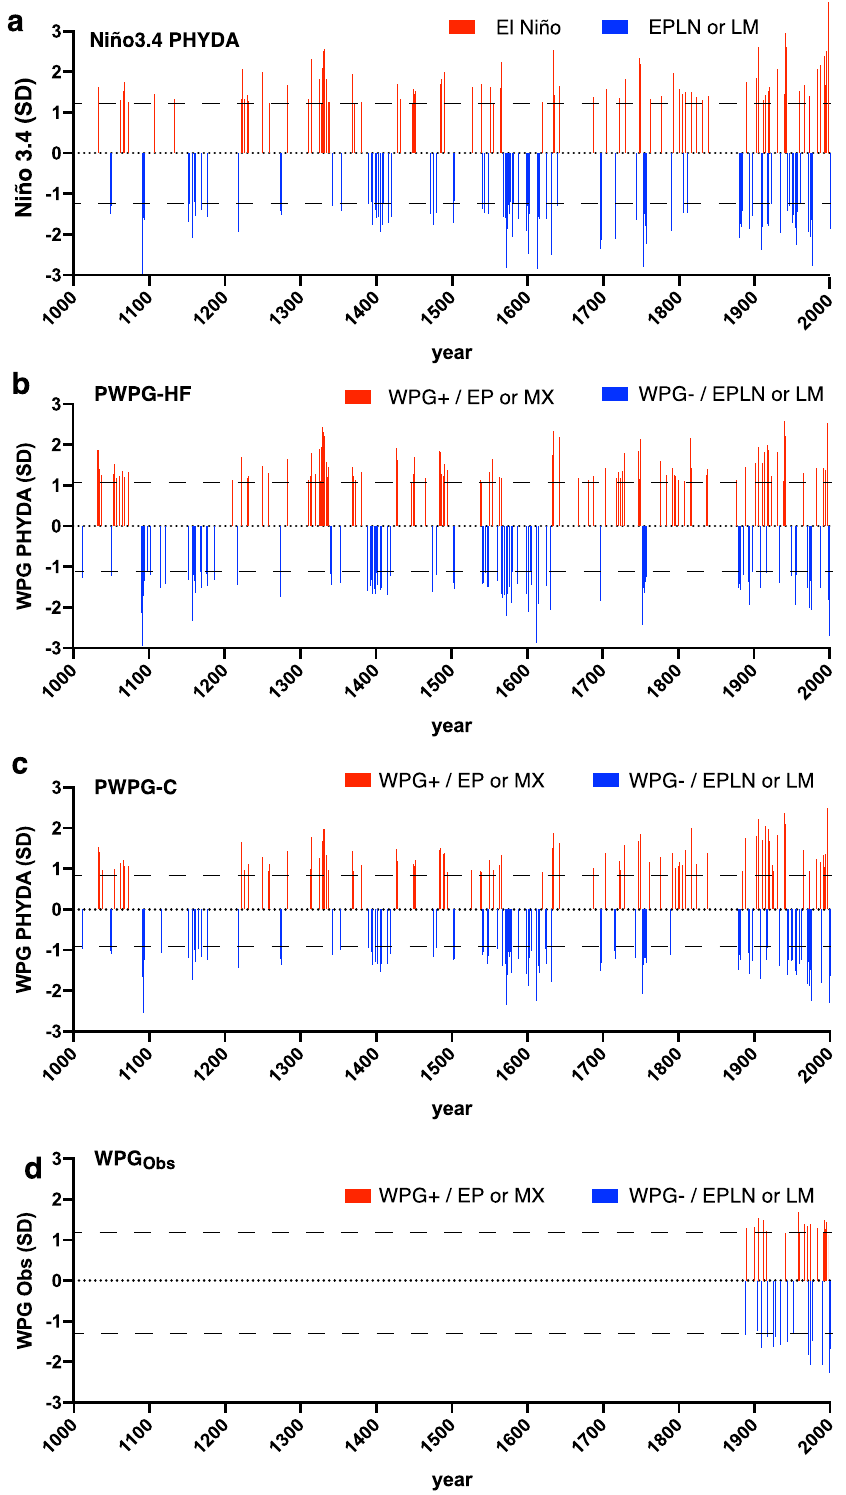
Figure 4. Extreme events based on 90th percentile of standardized and detrended indices. Time series were normalised relative to 1961–1990 (SD = standard deviation). ( a ) Niño3.4 index from PHYDA 34 , ( b ) PHYDA- WPG (PWPG-HF) based on Hoell and Funk 24 , ( c ) PHYDA-WPG (PWPG-C) based on Cai et al. 25 , and ( d ) observed WPG based on Hoell and Funk 24 . All positive (WPG +) and negative (WPG−) event thresholds > 90% percentile unique to each index illustrated by dashed lines. Only events that exceed the 90th percentile are shown. EP = eastern Pacific El Niño events, MX = mixed eastern-central Pacific El Niño events, EPLN = eastern Pacific La Niña, LM = La Niña Modoki-type